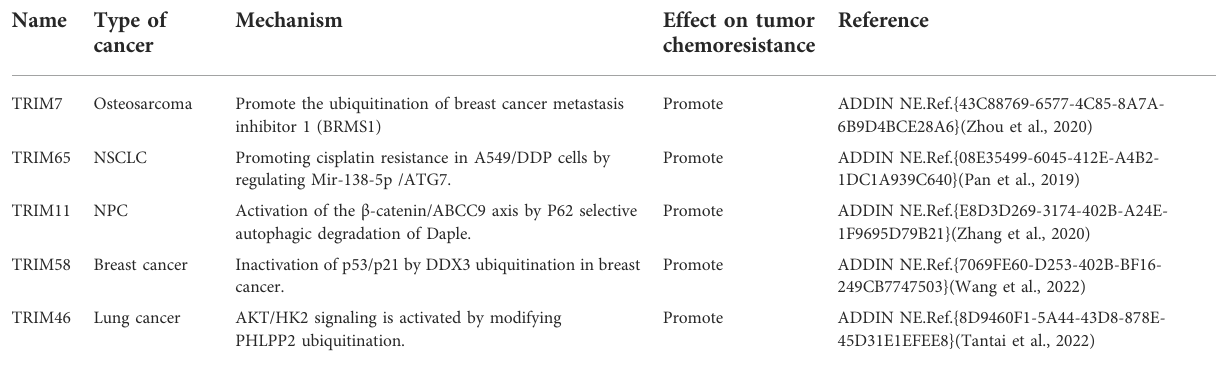
TABLE 4 Relationship between TRIMs and